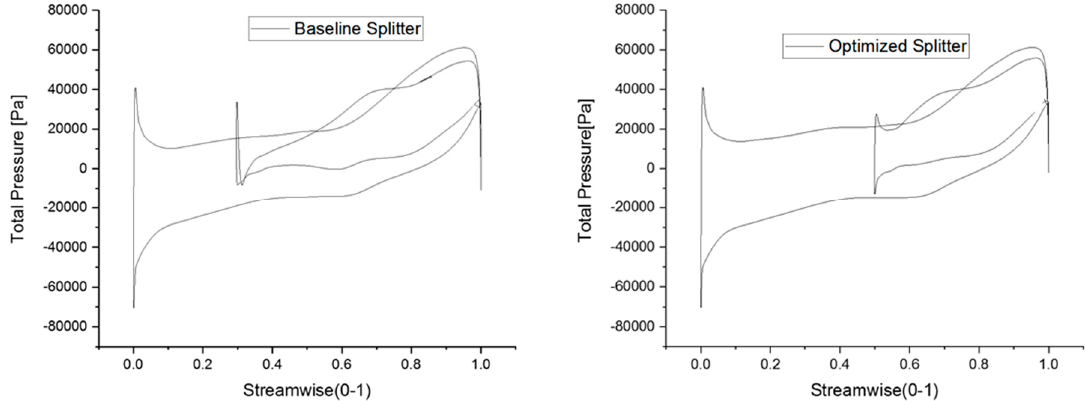
Figure 24. Blade loading comparison at span 0.8 for the baseline and optimized splitter blades.